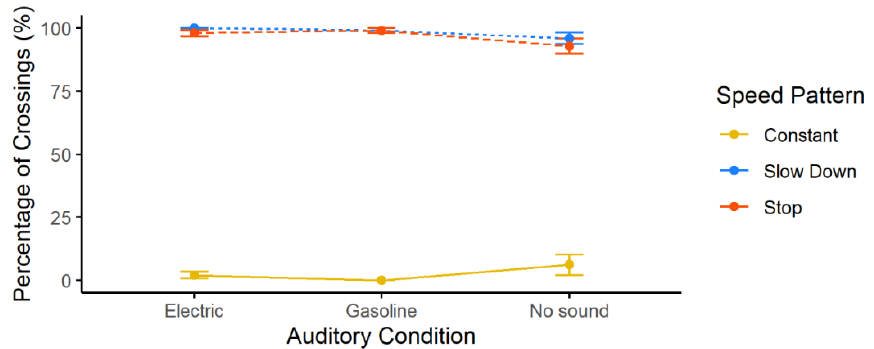
Figure 3. Percentage of crossings and respective mean, standard error as a function of auditory condition, per vehicle speed pattern.